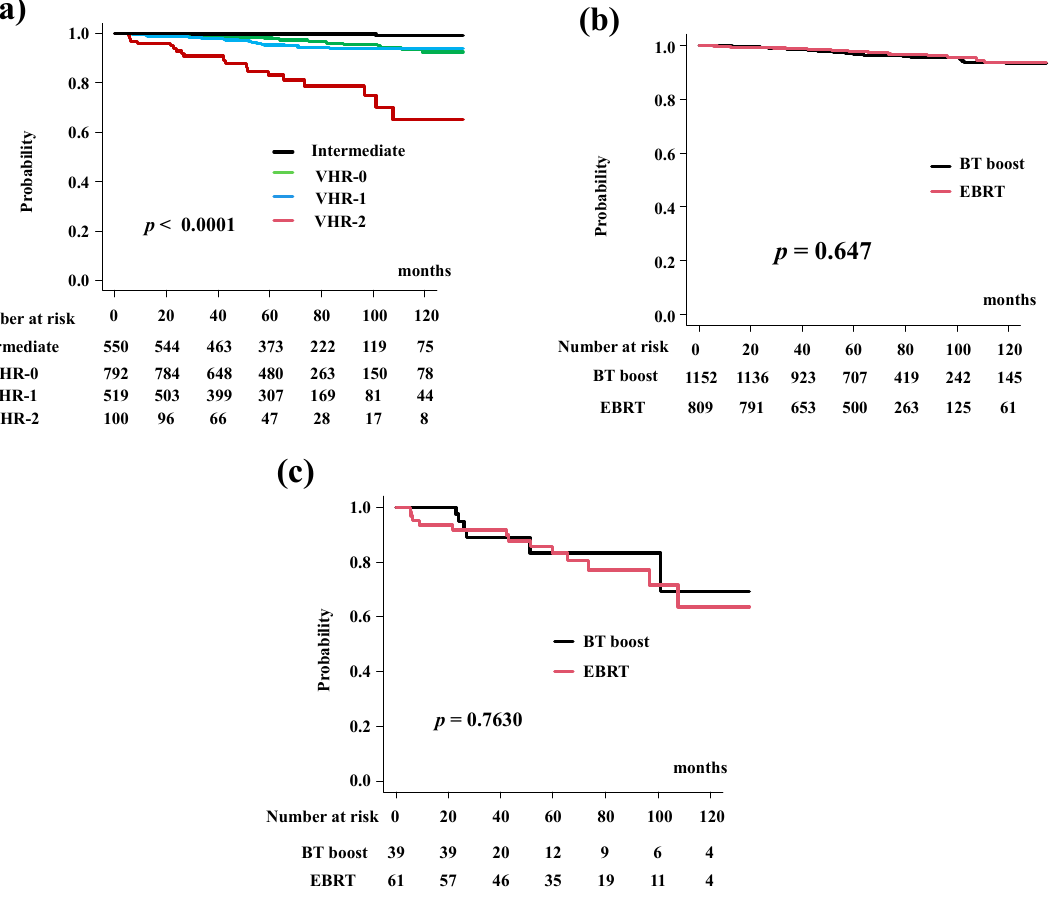
Figure 3. Distant metastasis-free survival rate (DMFS). ( a ) DMFS according to risk stratification. DMSF were 83.2% (95% CI: 72.9–89.8%), 95.4% (95% CI: 92.9–97.1%), 98.2% (95% CI: 96.8%–99.0%), 99.8% (95% CI: 94.8%–100%) at 5 years in the VHR-2, VHR-1, VHR-0, and intermediate groups, respectively ( p < 0.0001). ( b ) Comparison of DMFS between EBRT and BT-boost. ( c ) Comparison of DMFS between EBRT and BT-boost in VHR-2 group.